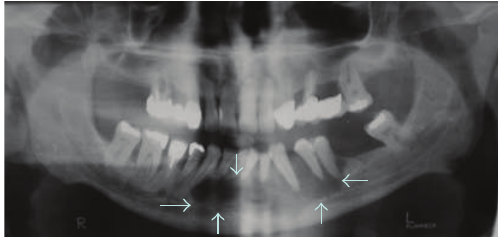
Figure 2: Case 1. Panoramic radiograph showing lytic multilocular lesion: